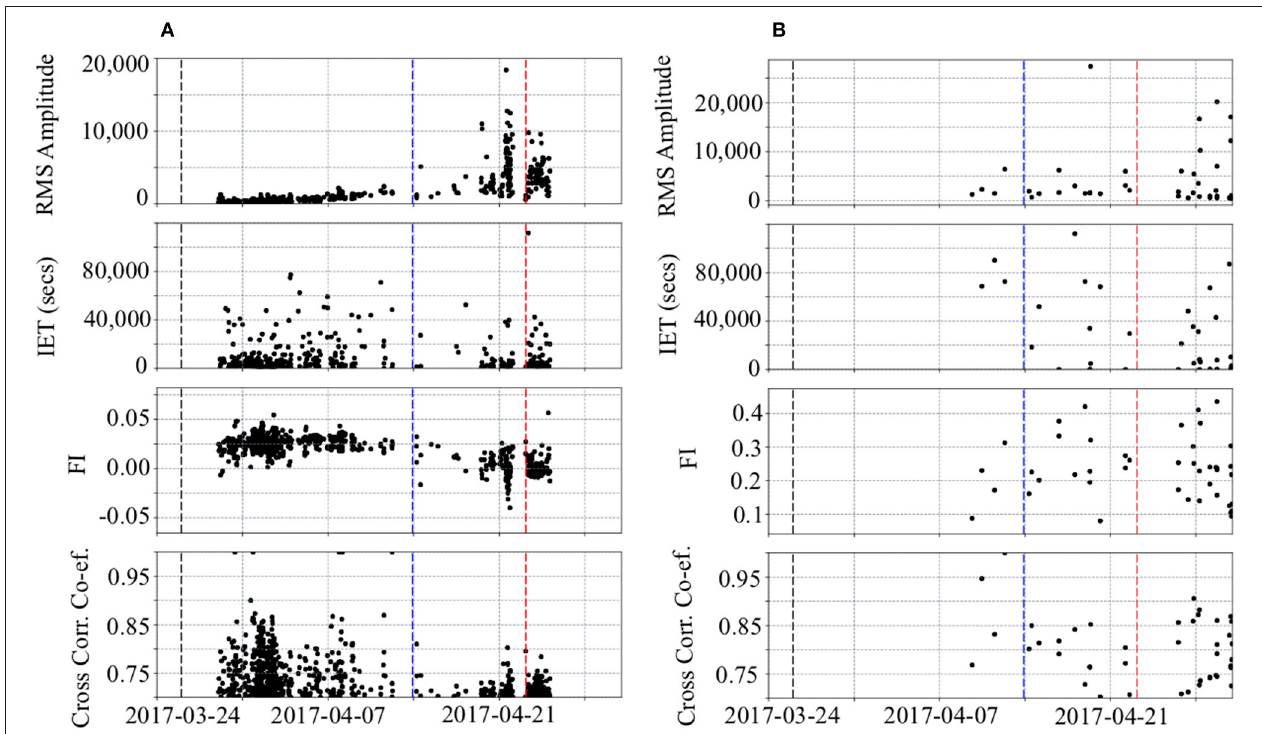
FIGURE 5 | Example of family analysis conducted on the dominant LF family [30-03-2017 08:46, (A) ] and the dominant VT family [12-04-2017 05:49, (B) ]. The dashed black line indicates the timing of increased VT activity counted by OVSICORI-UNA personnel (26 March), the dashed blue line indicates the beginning of daily phreatic eruptions (12 April), and the dashed red line indicates the timing of the large phreatomagmatic eruption (23